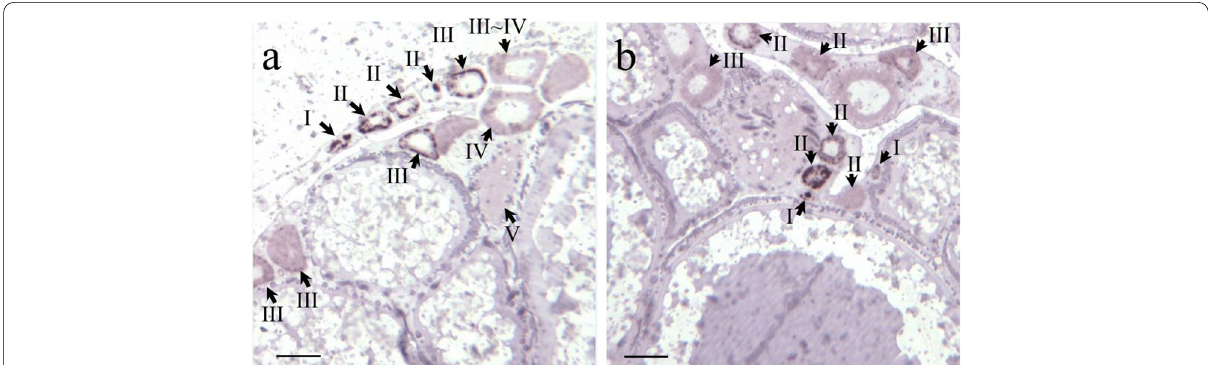
Fig. 3 The expression of mzpc5 in the ovary. Brightfield micrographs of mzpc5 transcripts detected in the ovary of a spawning female medaka using in situ hybridization. Scale bar 100 µm. The arrows point to mzpc5 expressed in oocytes of varying sizes. Panels a and b show different = portions of the same ovary. Only small oocytes (stages I–III) showed intense signals of mzpc5 expression